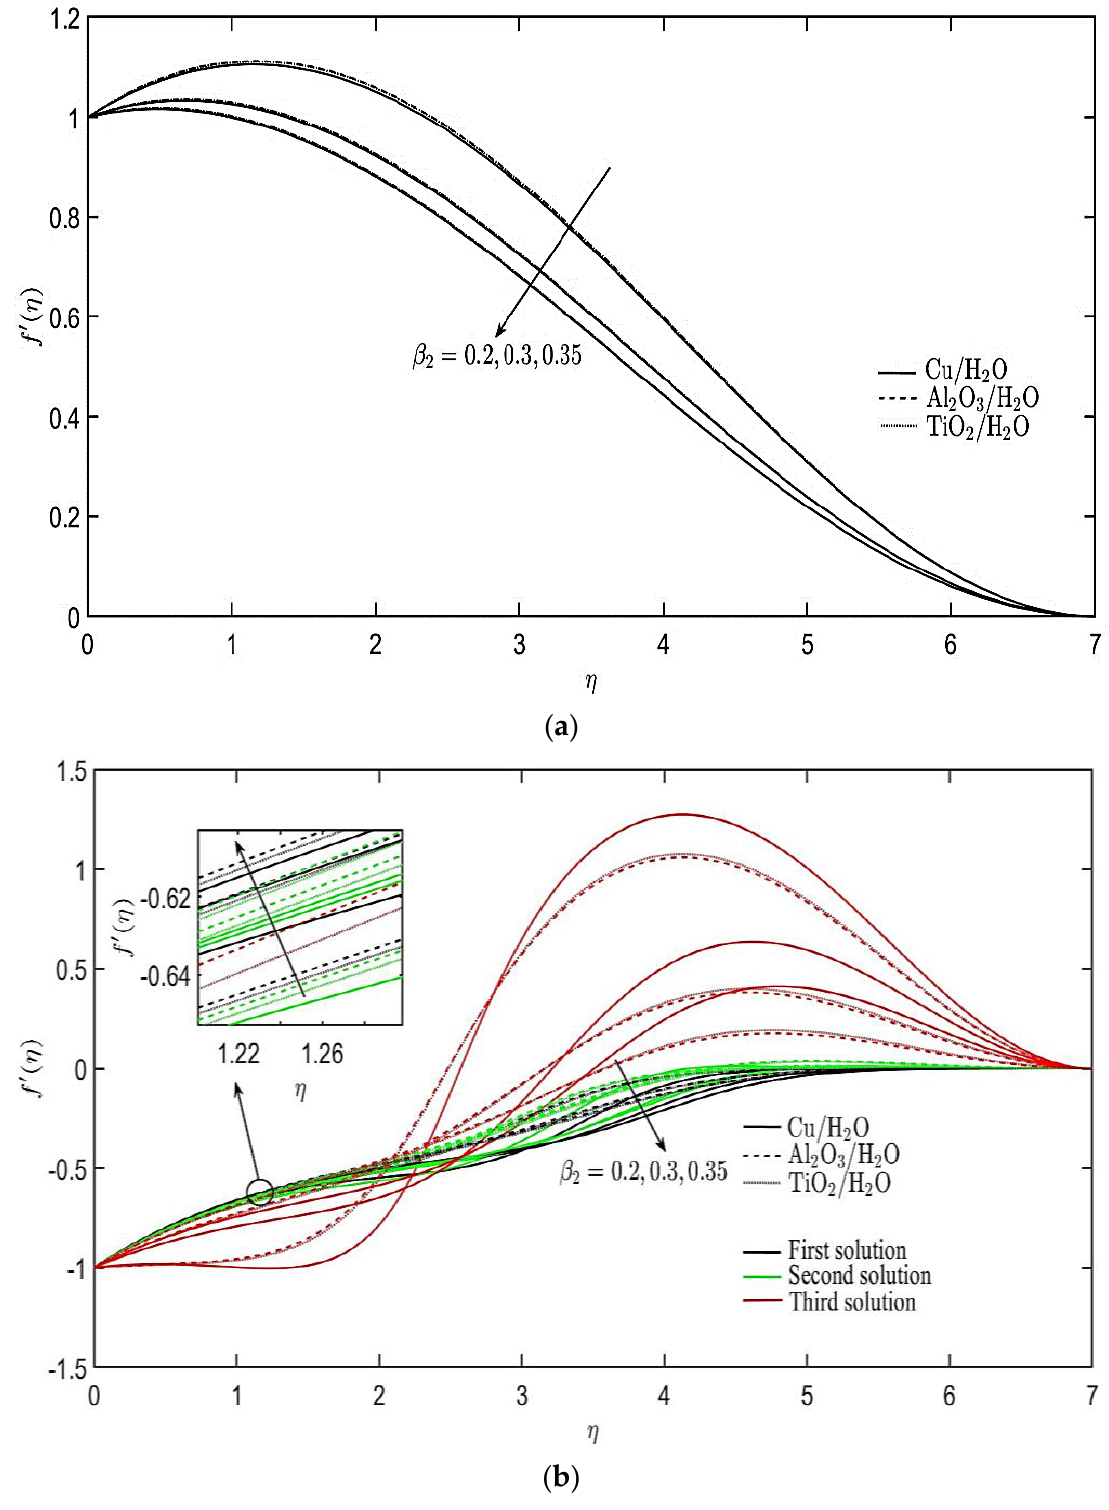
Figure 9. Effect of Burgers’ fluid parameter on velocity profiles for: ( a ) Stretching case; ( b ) Shrinking case.